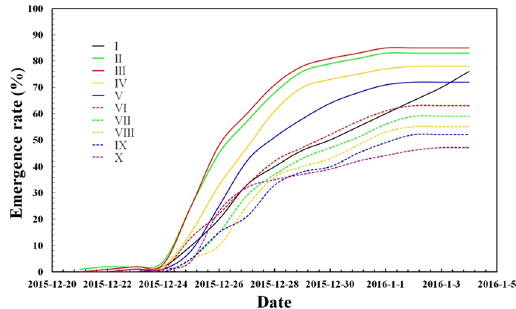
Figure 6. Emergence process of different grades of cultivated land.